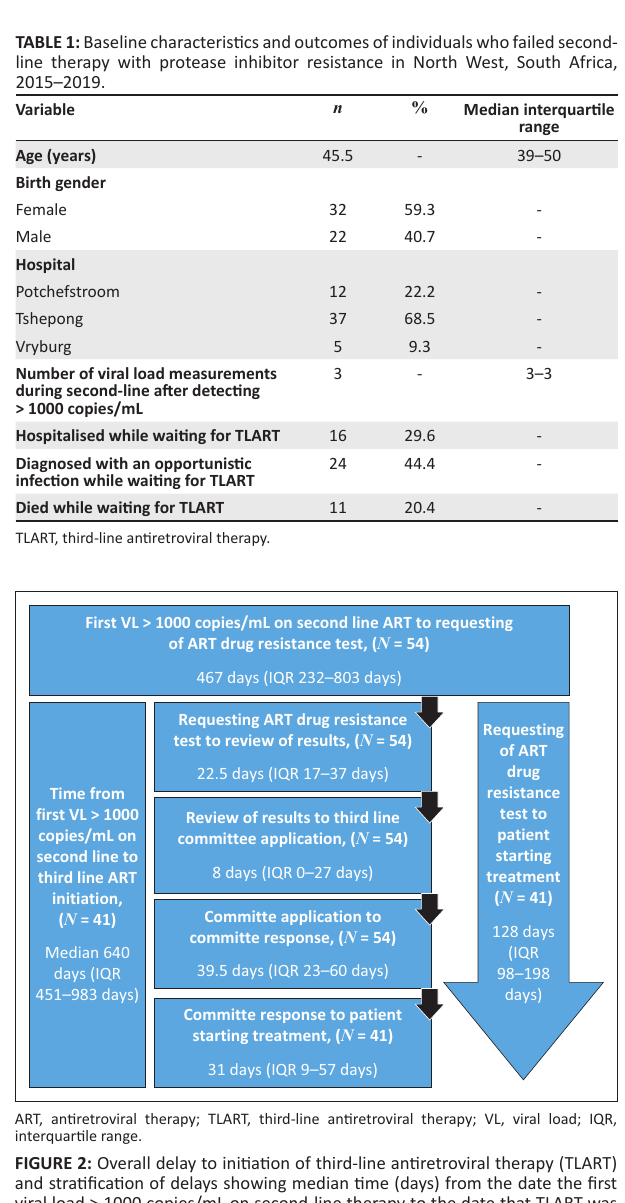
FIGURE 1: Study schema of patients diagnosed with protease inhibitor resistance on second-line antiretroviral treatment and identified as being candidates for third-line antiretroviral treatment in North West, South Africa.